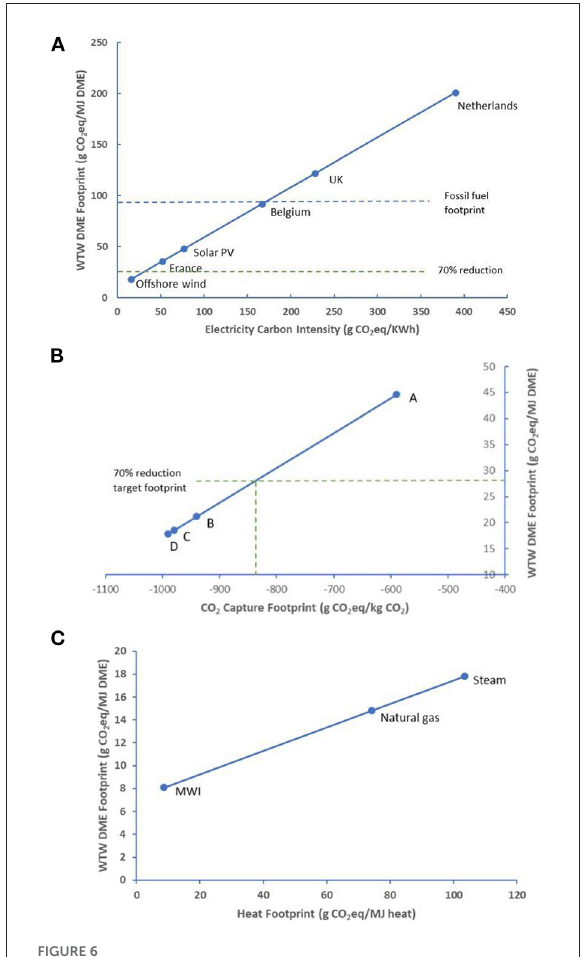
FIGURE6 The WTW carbon footprint of DME production and use plotted against: (A) the carbon intensity of the different electricity sources modeled. All assume CO 2 was captured from a bioethanol plant using renewable power and heat for DME production was from steam derived from the chemicals industry. Dotted lines indicate the fossil fuel footprint of 94g CO 2 eq/MJ and the 70% reduction target specified by RED II. (B) The CO 2 capture footprint. Assumes using offshore wind and heat from steam derived from the chemicals industry. CO 2 capture used: (A) DAC powered by EU grid electricity; (B) bioethanol plant flue-gas capture powered by EU grid electricity; (C) DAC powered by renewable energy; (D)